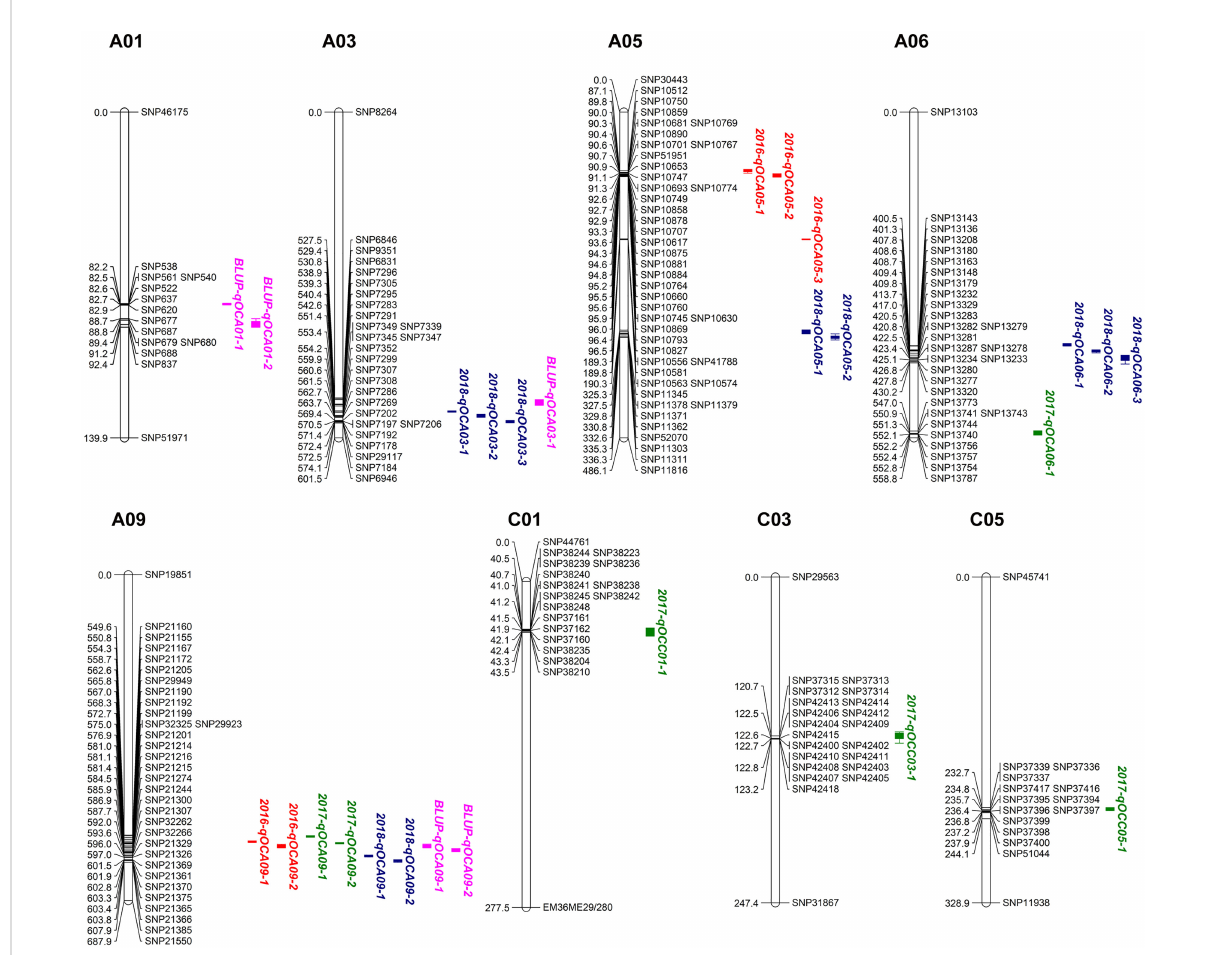
FIGURE 2 Putative QTL locations of seed oil content on the SNP genetic map. Red, green, blue and pink fonts represent QTL detected in 2016CQ, 2017CQ, 2018CQ and BLUP,